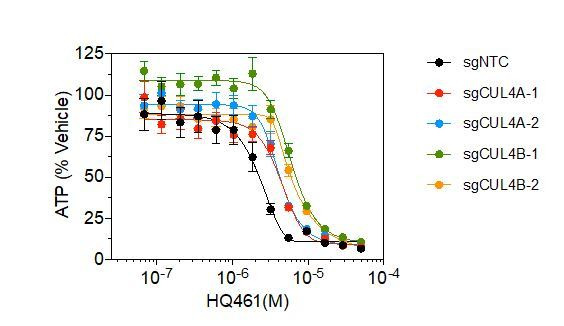
Measurement of the HQ461 IC50 on the viability of A549 cells expressing non-targeting control (NTC, IC50=2.3 μM) or two independent sgRNAs targeting CUL4A (IC50=4.4 μM, 4.2 μM), or CUL4B (IC50=6.0 μM, 6.3 μM).Error bars represent SEM from three biological replicates.